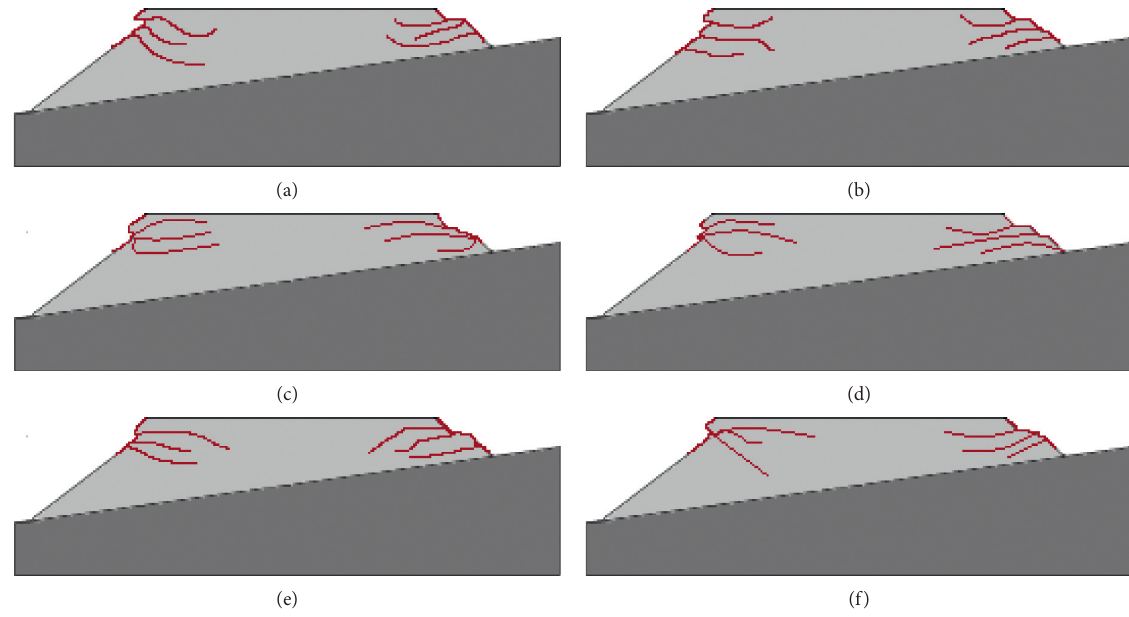
Figure 7: Embankment seismic damages of the 11th combination (F ( ε max � 1.7913). (b) Seismic damages of R � 4km ( ε max � 1.8931). (c) Seismic damages of R � 7 km ( ε max � 1.9736). (d) Seismic damages of R � 10km ( ε max � 1.8433). (e) Seismic damages of R � 13km ( ε max � 1.8408). (f) Seismic damages of R � 15km ( ε max �